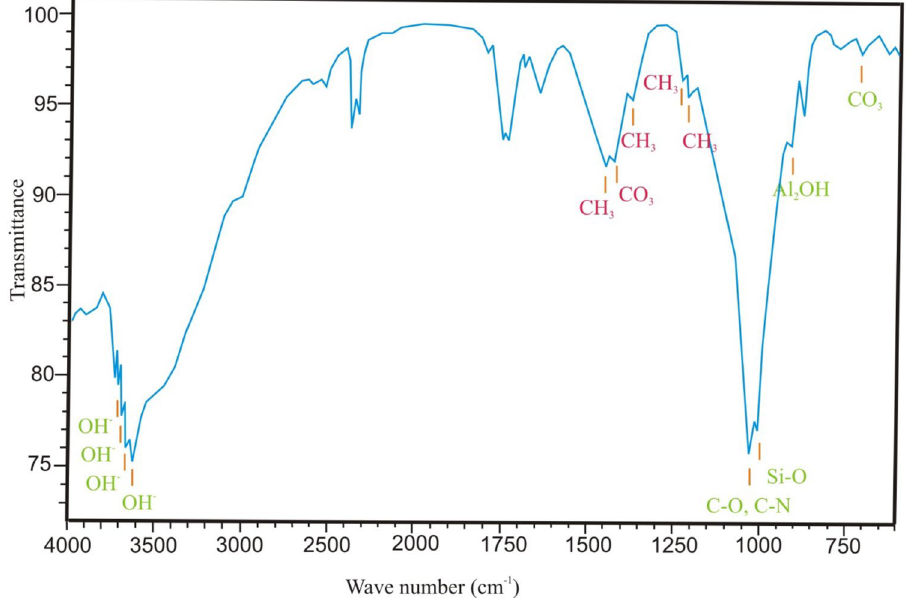
Fig. 9 Representative SEM micrographs and EDS traces for the Kömürlü and Penek Formations sandstones. a Illite (I) minerals are present as a grain coating and flake morphology in the SEM micro- graphs. Dominant illite (I) peak is K element in the EDS spectrum (a single well, The Kömürlü Formation, depth: 2368 m, sample 4). Fig. 10 The FTIR spectrum of sandstone–shale (the Kömürlü Formation) well sample. A single well; depth: 2360 m, sample